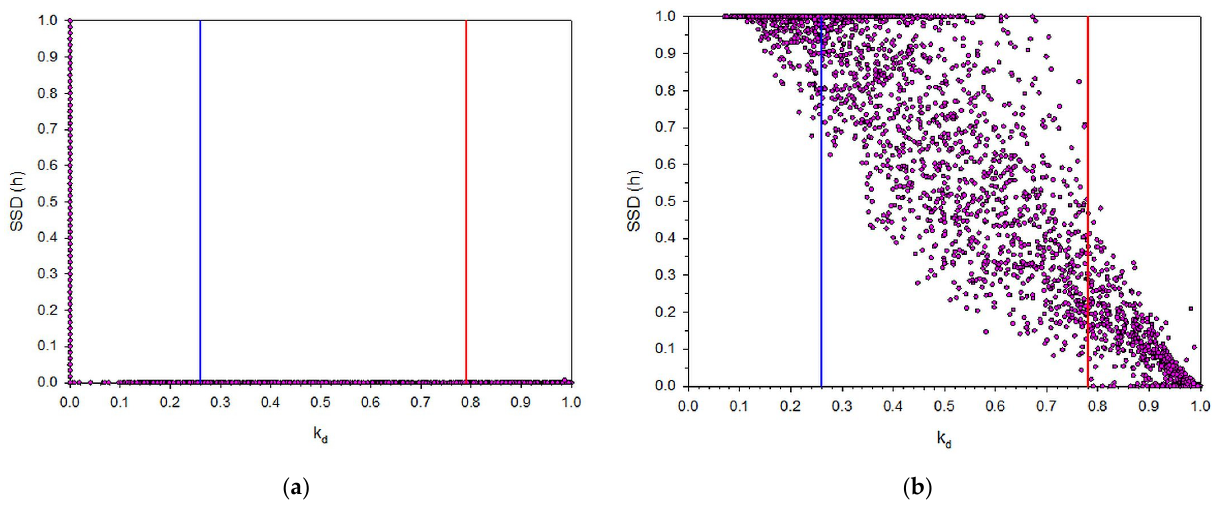
Figure 14. Determination of clear, intermediate, and overcast skies for the ( a ) ILO and ( b ) KIS sites.